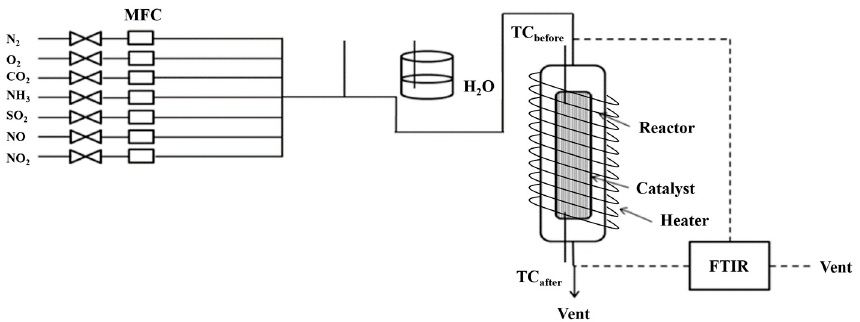
Figure 5. Schematic diagram of the micro reactor.